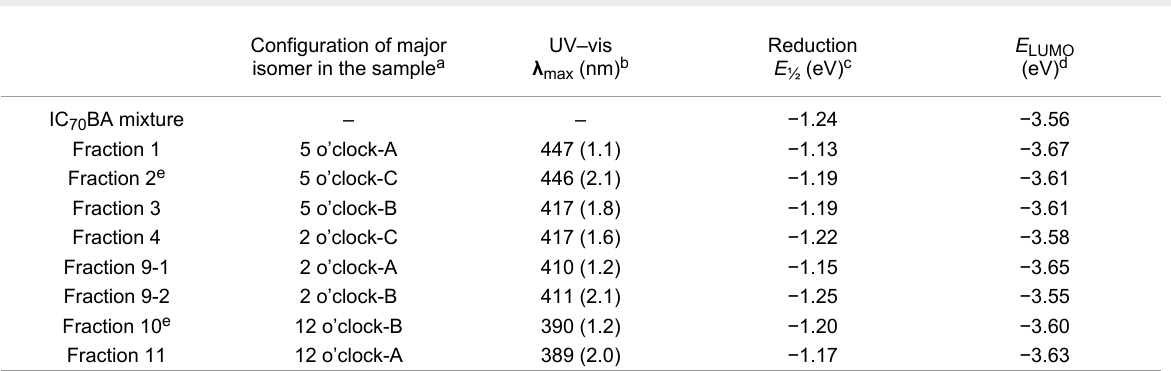
Table 1: Characterization data of various IC 70 BA fractions.